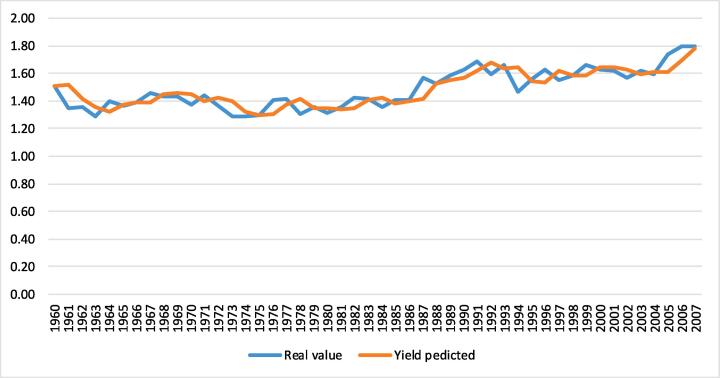
Validity of the ARIMA model of yield prediction.